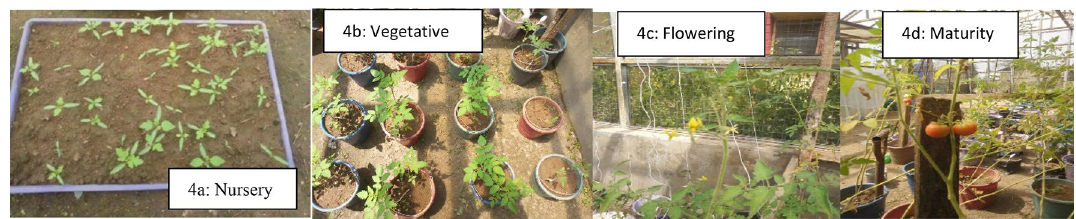
Figure 10. ( a – d ) Nursery, vegetative, flowering and maturity/harvesting stages of tomato